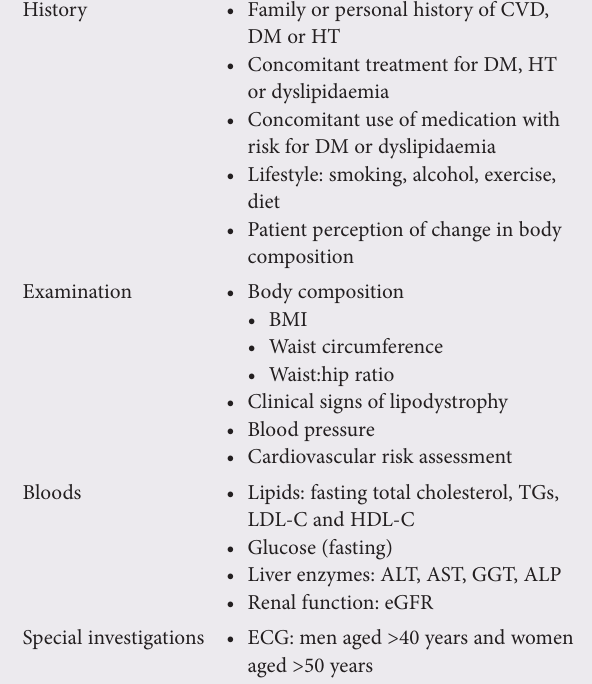
Table 2. Suggested annual screening for metabolic complications